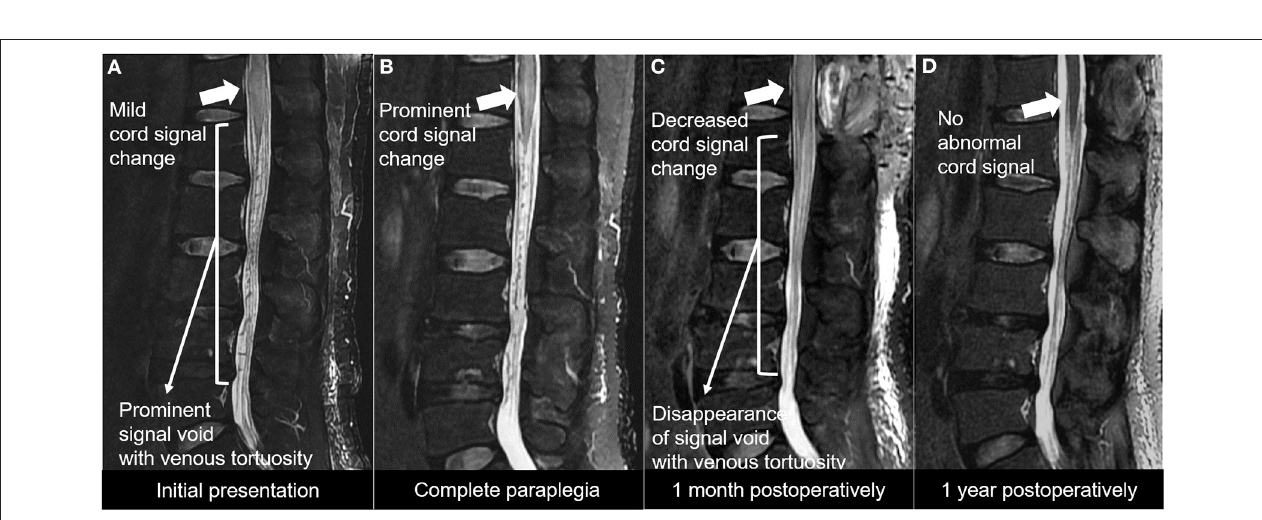
FIGURE 2 | (A) T2-weighted MRI study showing prominent signal void with redundant venous tortuosity, which represents spinal arteriovenous fistula. (B) T2-weighted MRI study showing worsening of spinal cord signal change. (C) T2-weighted MRI study at post-operative 1 month showing decreased cord